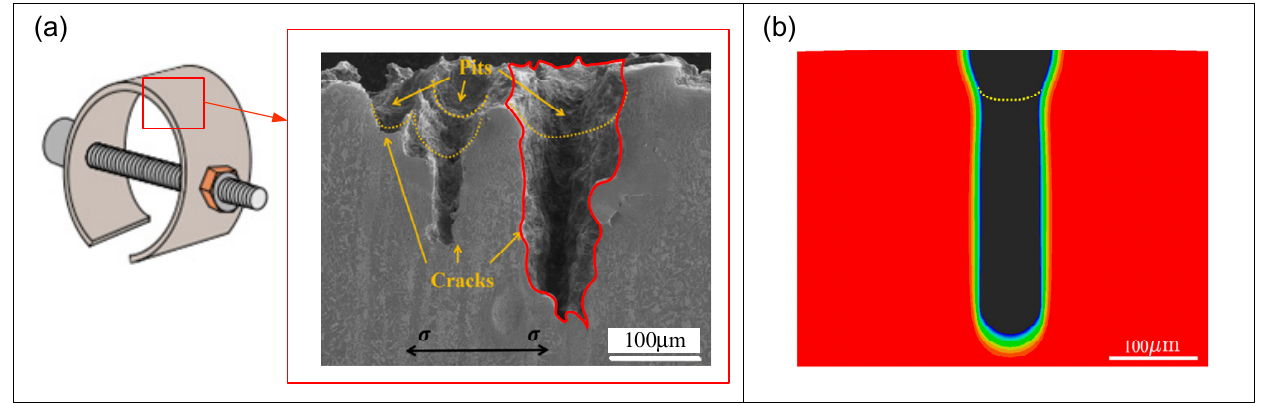
Figure 7. Corrosion fracture. ( a ) Experimental observation and ( b ) simulated crack of the C-ring